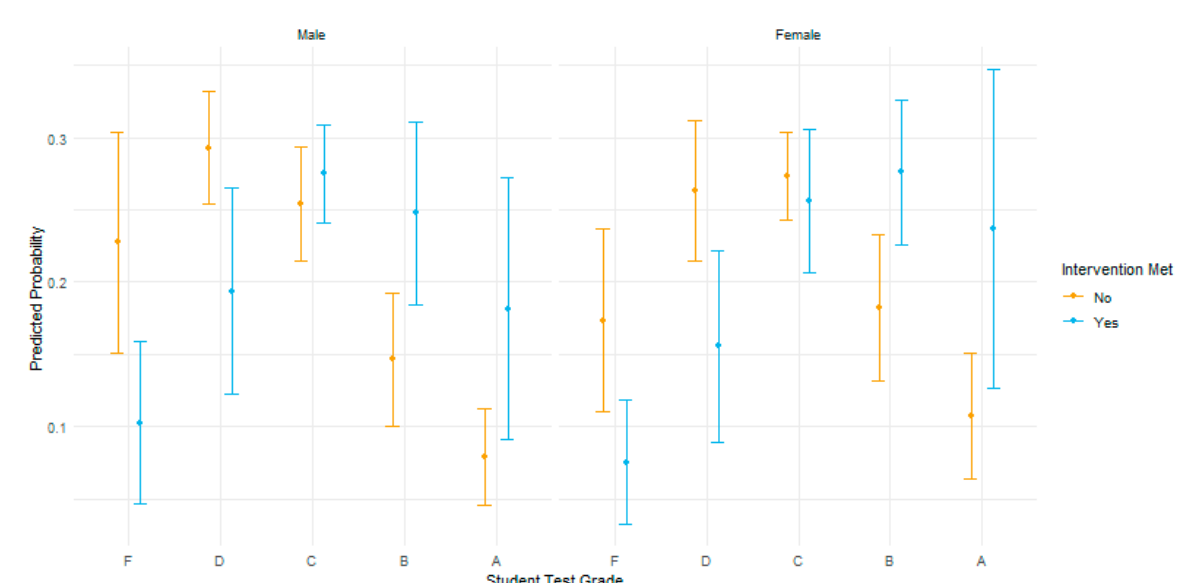
Figure 3. SNLS predicted grade probabilities by gender and intervention .